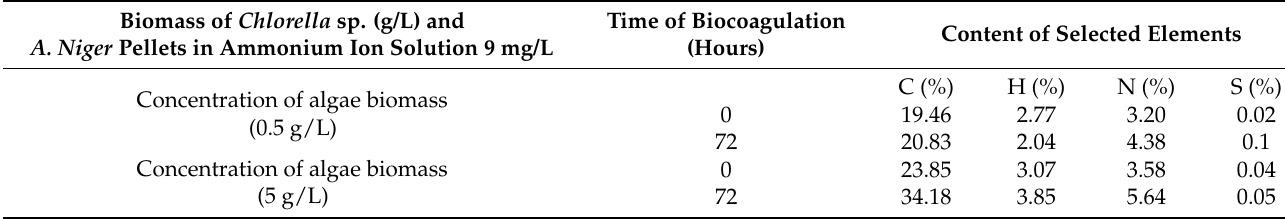
Table 3. Measured values of selected biogenic elements after flocculation (72